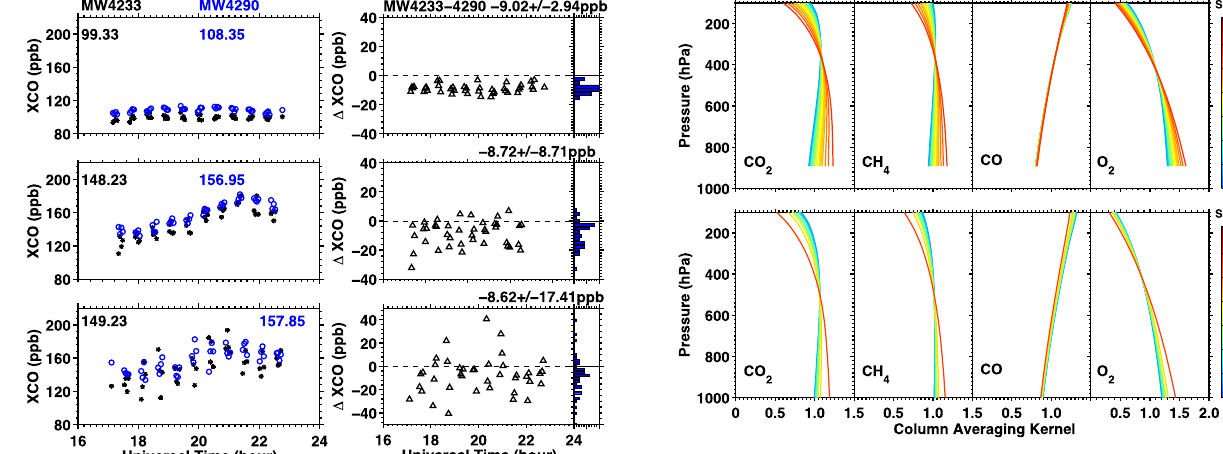
1 Fig. 13. Column-averaging kernels of GHG measurements using Figure 13 . Column averaging kernels of GHG measurements using CLARS-FTS with a 2 Maximum Optical Path Difference (MOPD) of 5 cm. Top panels: for the measurements over 3 CLARS-FTS with a maximum optical path difference (MOPD) of CLARS site in the Spectralon viewing geometry; bottom panels: for the measurements 4 targeting the land surface of Arcadia race track (34.141 N, 118.042 W, 155 meters above sea 5 5cm. Top panels: for the measurements over the CLARS site in the level, 9.3 kilometers slant distance to CLARS site), Arcadia, California. 6 Spectralon ® viewing; bottom panels: for the measurements target- ing the land surface of Santa Anita Park (34.141 ◦ N, 118.042 ◦ W, 155m above sea level, 9.3km slant distance to the CLARS site), Arcadia,